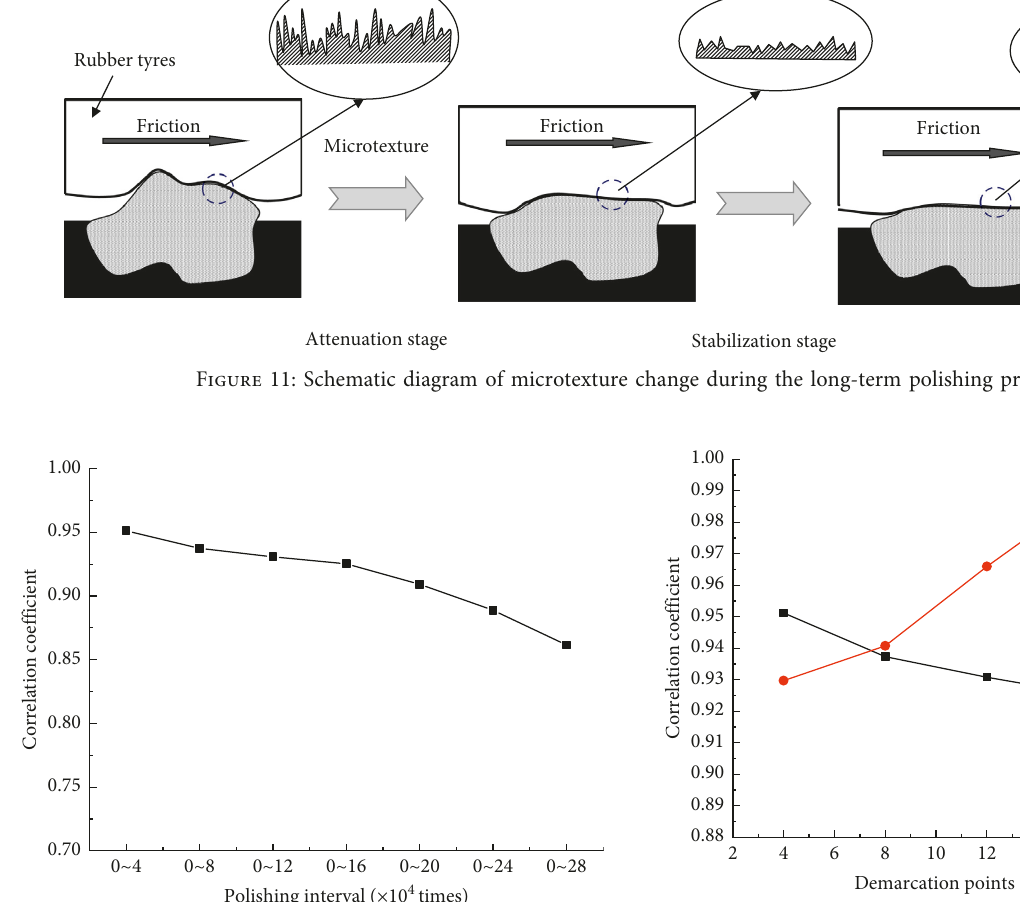
Figure 12: Pearson correlation coefficient between PSV and D at different polishing intervals.